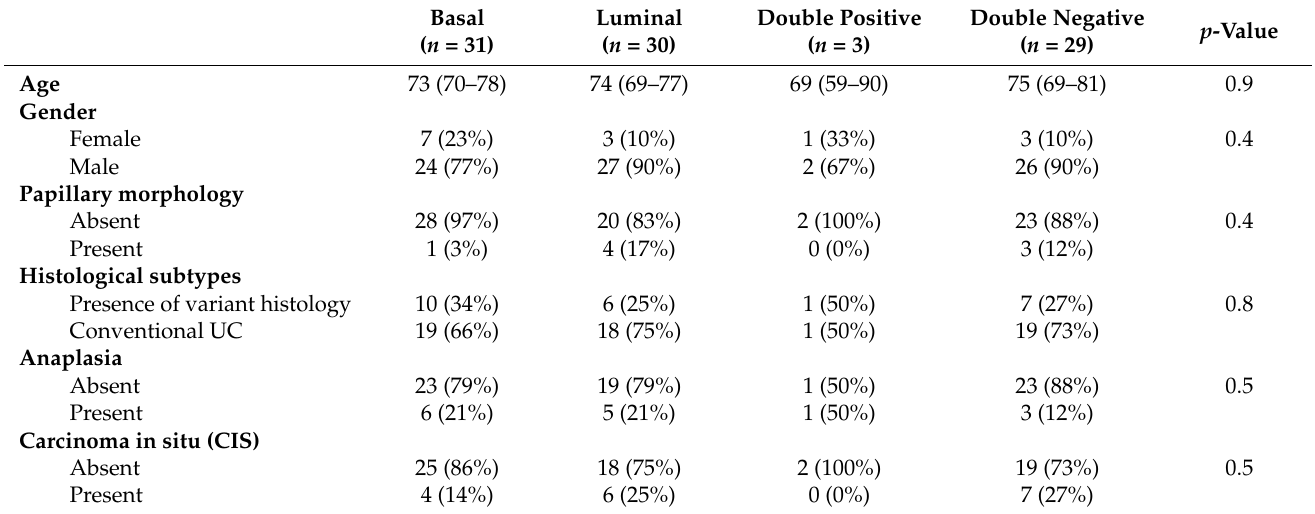
Table 3. Association between molecular subtypes obtained through Scheme #1 and clinicopathological